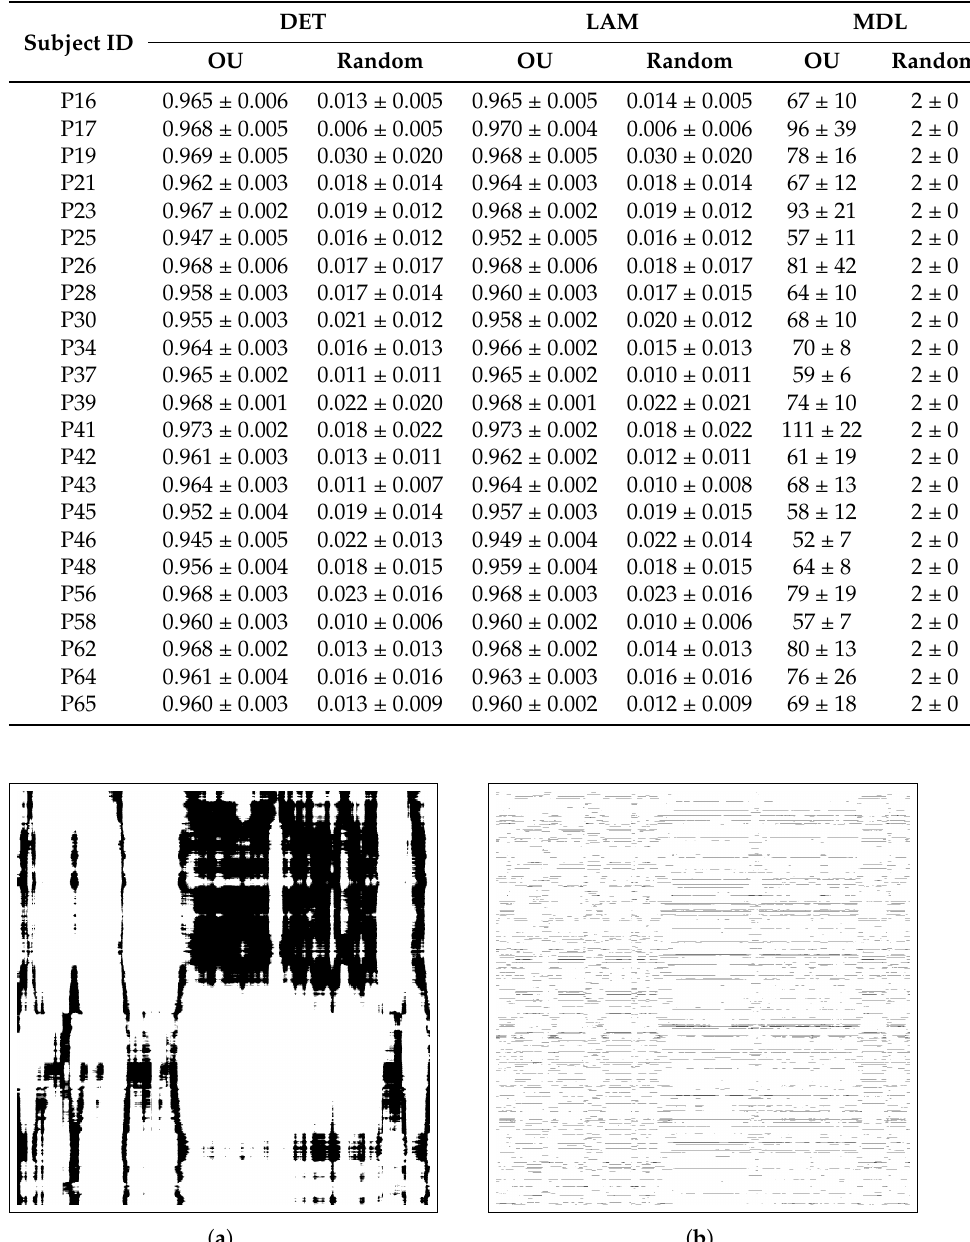
Table 1. Results of the Cross Recurrence Analysis (CRA) conducted among the V/A trajecto- ries from human raters and 10 emulated raters for each of the 23 subjects. The table reports the mean values ( ± standard deviation) of three quantitative measures, namely Determinism (DET), Laminarity (LAM), and Maximum diagonal line length (MDL). The results of these measures are compared against those of 10 random raters.